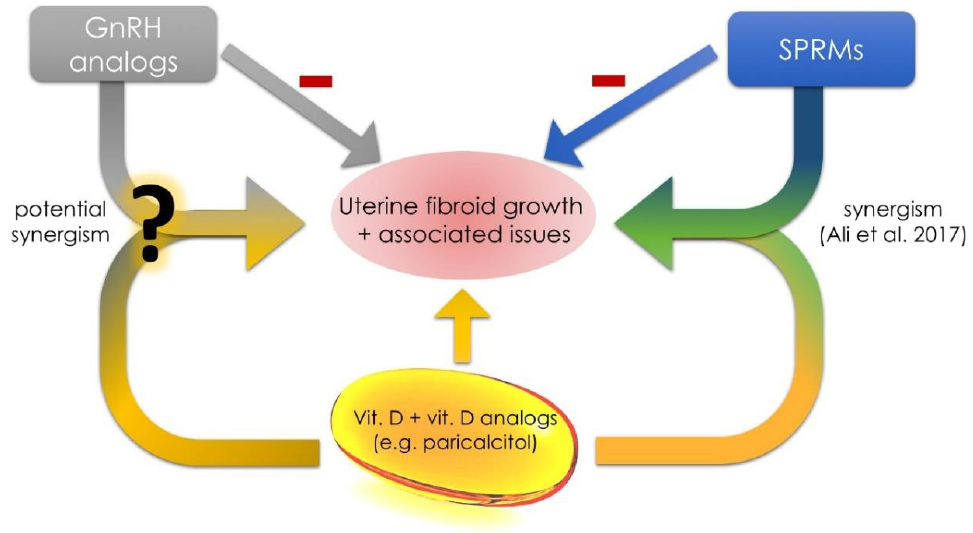
Figure 3. Vitamin D, GnRH analogs and SPRMs. According to Ali et al. there is a potential synergism between vitamin D and ulipristal acetate [140]. New data about between vitamin D, vitamin D analogs and other mostly used drugs in UF therapy is necessary to find other synergisms. Gonadotropin releasing hormone (GnRH), selective progesterone receptor modulator (SPRM).